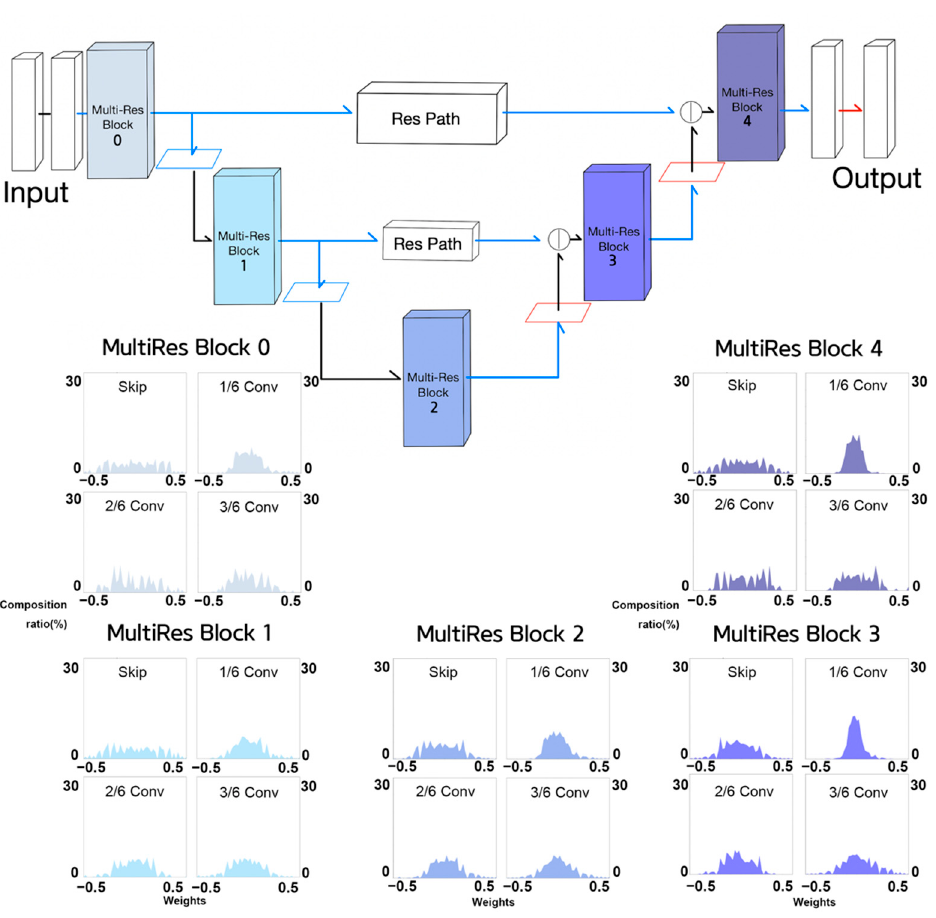
Figure 13. Weight histograms of each component of MultiRes blocks in Half MultiResUNet.